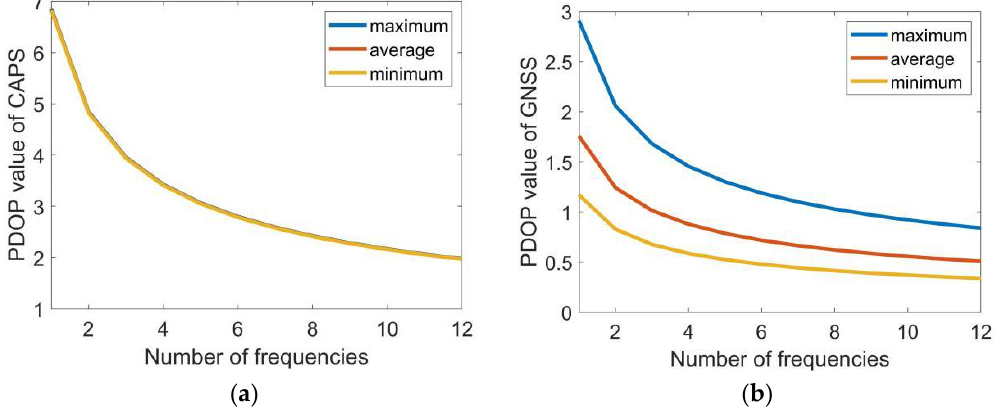
Figure 7. The change of the PDOP value with the increase of the number of frequencies. Subfigures ( a,b ) are corresonding to the CAPS system and the GNSS system, respectively.